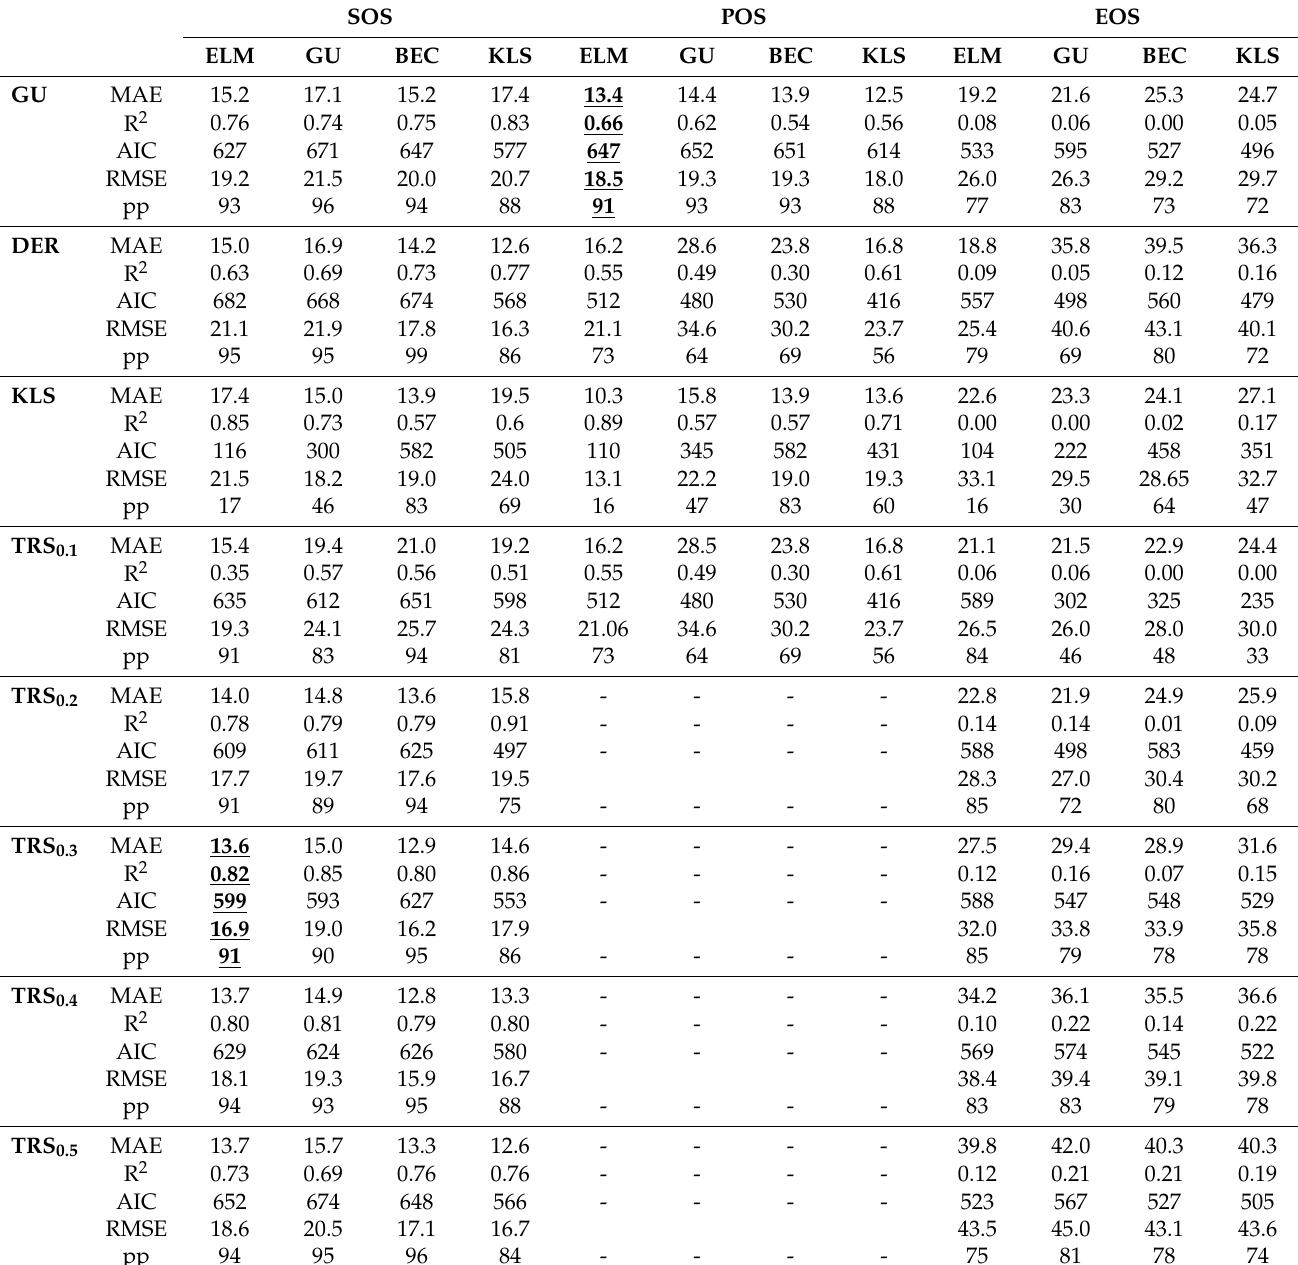
curve (TRS = 1). As shown in Table 3, the best results in POS calculation were obtained with ELM × GU and BEC × GU. Table 3. Goodness of fit indicators between phenological dates extracted from GPP and kNDVI patterns with different FM × EM approaches. The results underlined and in bold are those relating to the approach chosen for the start (SOS) and peak (POS) of the season, respectively. SOS POS